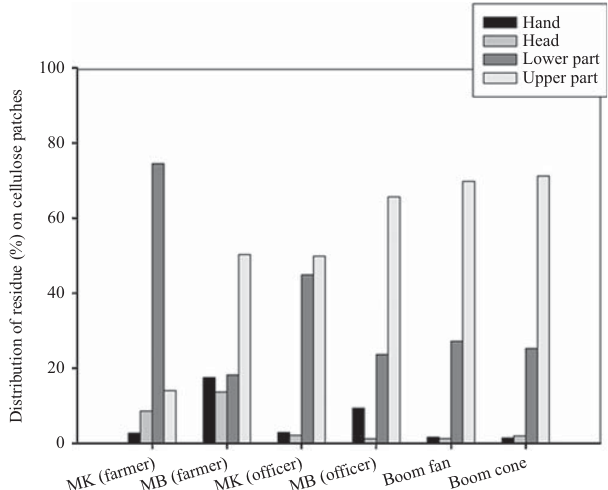
Figure 2. Extrapolation of residues on cellulose patches to surface contamination of body parts according